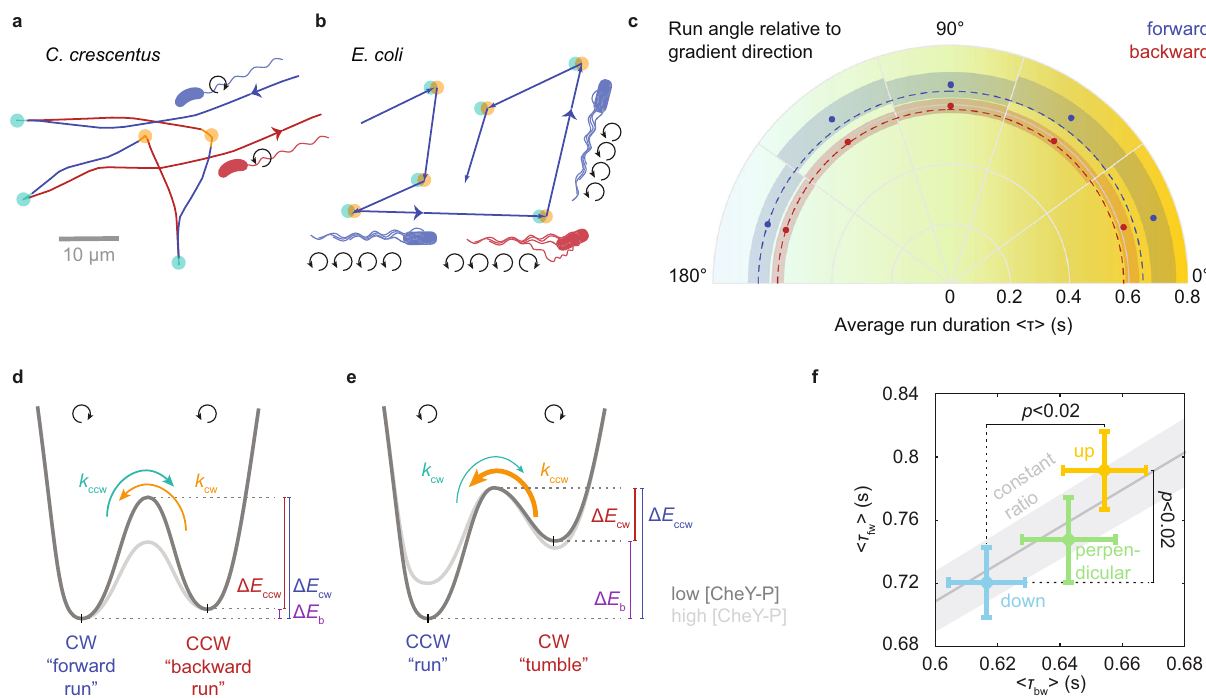
Fig. 2 C. crescentus chemotaxis. a Example trajectory showing alternating backward (red) and forward (blue) runs, separated by switches in fl agellar rotation direction that result in reversals (CW to CCW, teal) or fl icks (CCW to CW, orange). b Schematic of E. coli run-tumble motility. Runs are driven by CCW rotation (blue). Tumbles result from temporary CW rotation (red) of at least one fl agellum and thus are bordered by two switches in rotation direction (CCW to CW, teal, CW to CCW, orange). c Radial plot of average run durations (blue: forward, red: backward runs) as a function of projected angle to the x -axis in the x - y plane. The dashed lines indicate the average run durations observed for swimming down the gradient and serve to facilitate comparison. Shading indicates 95% con fi dence intervals. Values are computed from a total of 2898 forward and 5342 backward runs. d Schematic of two- state motor rotation model proposed for C. crescentus and e established for E. coli 38, 39 . The energy difference Δ E b (purple) between states determines the motor bias, while the energy barrier between states, Δ E ccw and Δ E cw , determines the switching rates, k cw and k ccw , respectively (see Supplementary Discussion). f Average forward versus backward run durations, < τ fw > versus < τ bw > , up (yellow), down (cyan), or perpendicular to (green) the gradient (de fi ned by 36° cones around positive x -axis, negative x -axis, or y -axis, respectively). The solid line re fl ects a best- fi t constant CW bias of 0.54 ± 0.01, with the standard error (Methods) shown as gray shading. P values are shown for one-sided t -tests between durations up and down the gradient. Error bars re fl ect standard error of the mean. Averages and p values are determined over 506, 449, 408 forward runs and over 882, 946, 835 backward runs ascending (yellow), descending (cyan), and perpendicular to (green) the gradient,